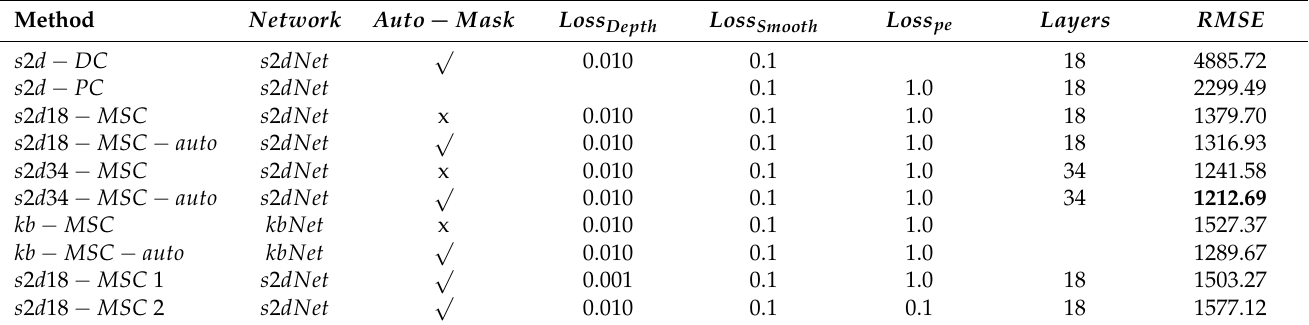
Table 1. Comparison of self-supervised methods for different sequence modality constraints. The bold numbers are the